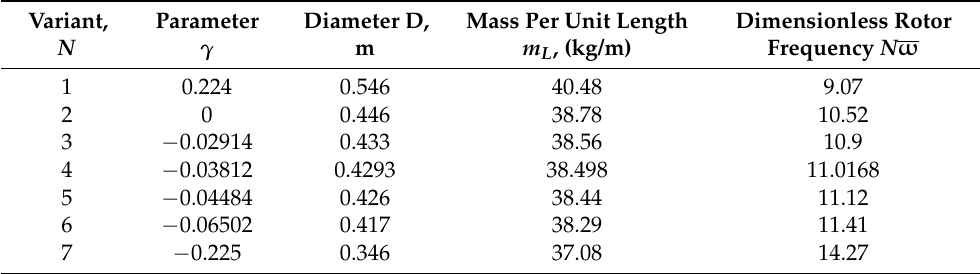
Table 3. Equivalent mass and diameter of tail